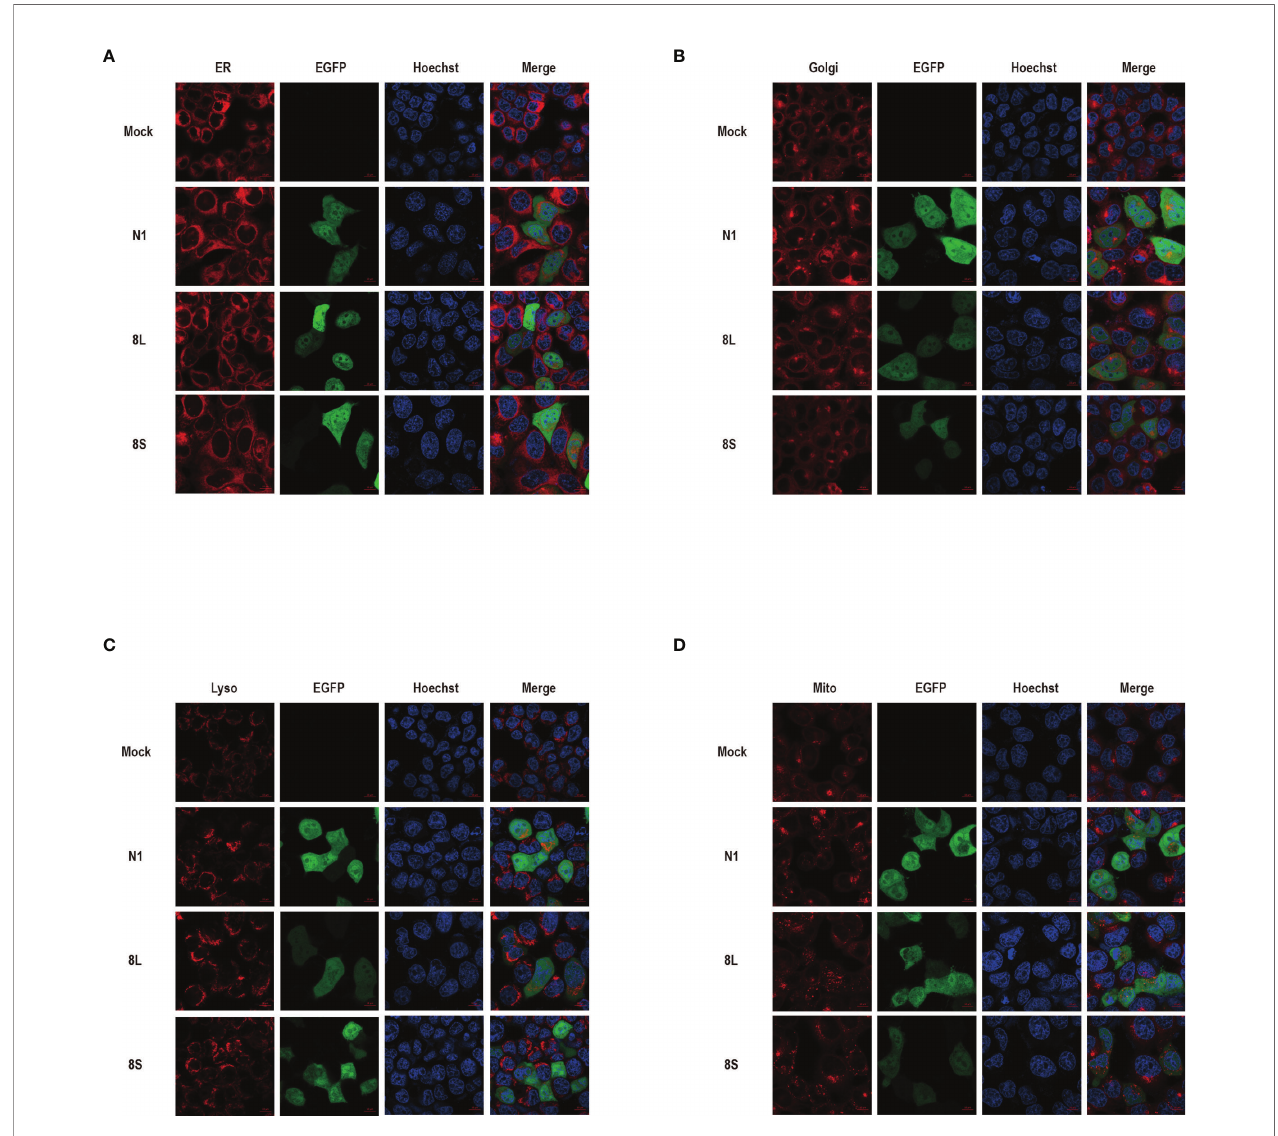
FIGURE 2 | The cellular sub-localization of SARS-CoV-2 ORF8L, and ORF8S proteins. HeLa cells were transfected with pEGFP-N1, pEGFP-ORF8L, and pEGFP- ORF8S for 48 h; fi xed; and then stained with Tracker-Red against endoplasmic reticulum (A) , Golgi apparatus (B) , lysosome (C) , and mitochondria (D) (red). ORF8L and ORF8S proteins were shown in green while nucleus was visualized with Hoechst (blue). Confocal imaging results are representative of two independent experiments. Scale bar, 10 m m. Endoplasmic reticulum, ER; Golgi apparatus, Golgi; lysosome, Lyso; mitochondria, Mito; pEGFP-N1, N1; pEGFP-ORF8L, 8L; pEGFP-ORF8S, 8S; hours,